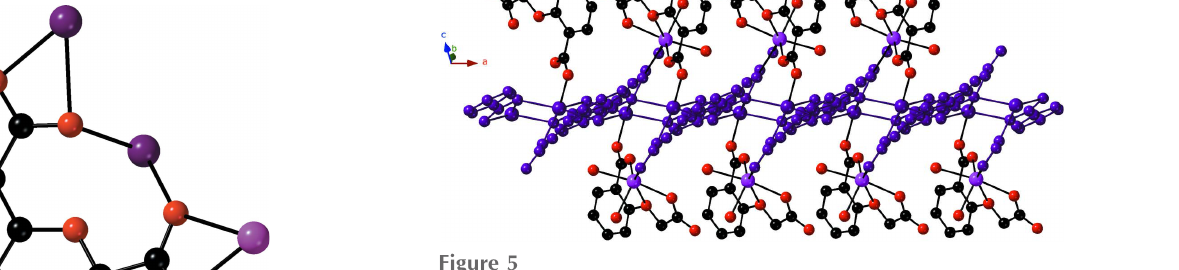
Figure 5 [Cd 2 (cmb) 2 (H 2 O) 2 )] n coordination polymer ribbon in the title compound, oriented parallel to the a axis. The inner chain sub-motif is shown in purple.